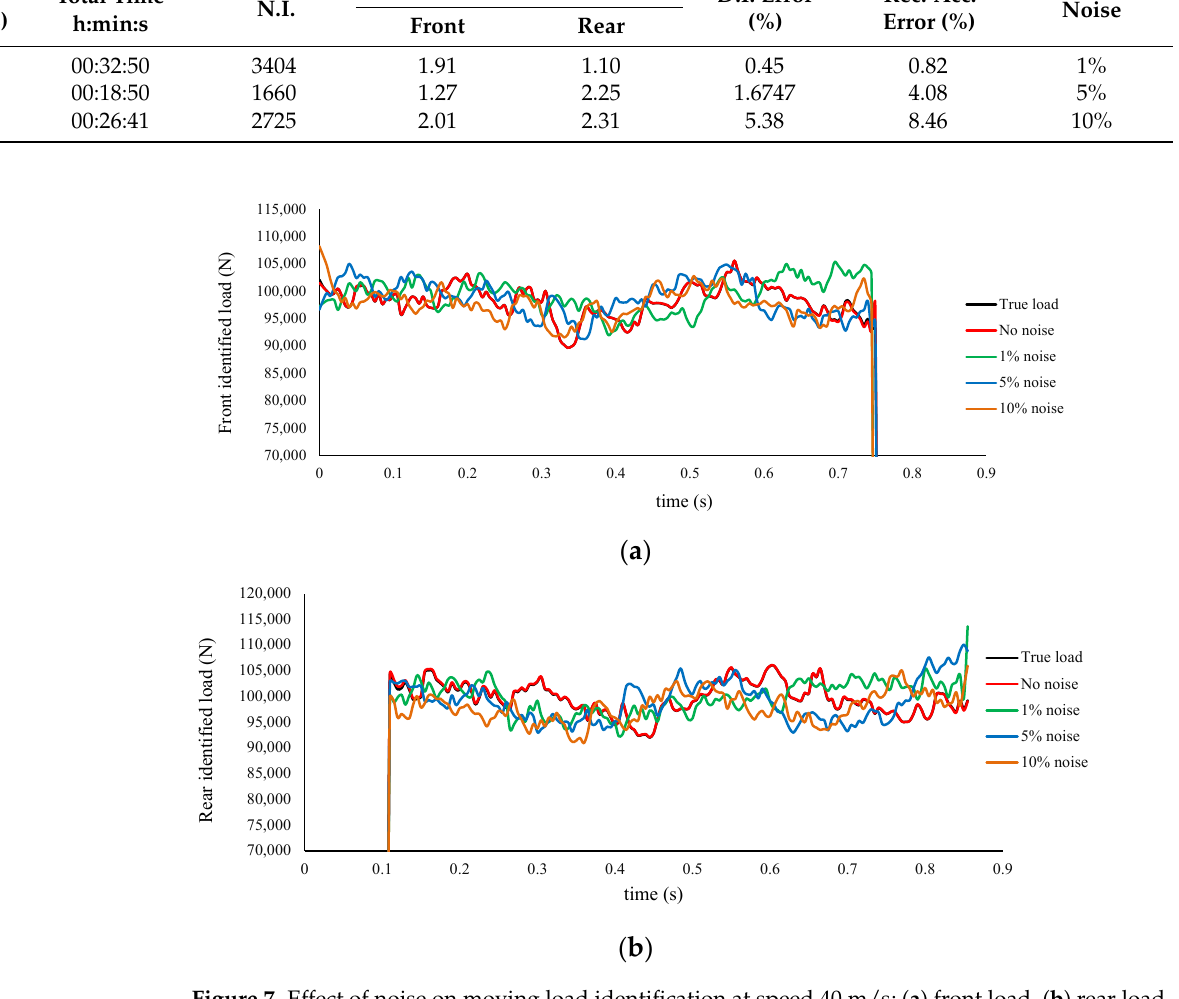
Figure 7. Effect of noise on moving load identification at speed 40 m/s; ( a ) front load, ( b ) rear load.